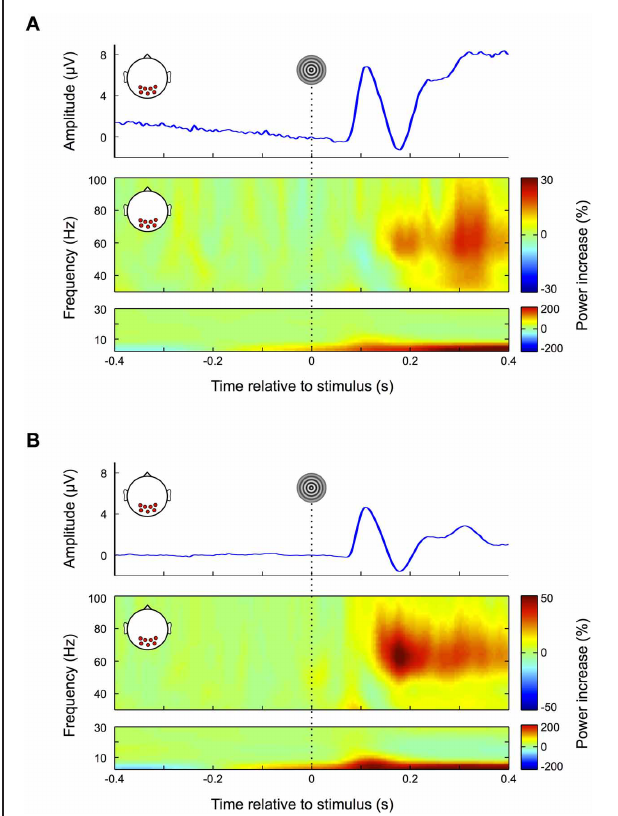
FIGURE 3 | Visual response. (A) Nose-referenced data. During fixation trials the average ERP over occipital electrode sites displays a clear visual response (upper panel), i.e., an early transient response, followed by a prolonged increase in amplitude. In the gamma frequency range (30–100Hz, middle panel) power increases from about 180ms until the end of the trial. Unlike similar responses in earlier studies at source level the power increase here is not restricted to a defined frequency band over its whole time course but also spreads over the whole gamma range in the later portion of the trial. The power increase in the lower frequency range (0–30Hz, lower panel) broadens in bandwidth coinciding with the transient response in the ERP. (B) Average-referenced data. Similar to (A) the ERP displays an early transient and later prolonged response; however, the signal is smoother with lower amplitudes (upper panel). Compared to the nose referenced data, the prolonged response in the gamma frequency band is now more pronounced and confined to a relatively narrow frequency range (middle panel). Similarly the early visual response in the low frequencies is more